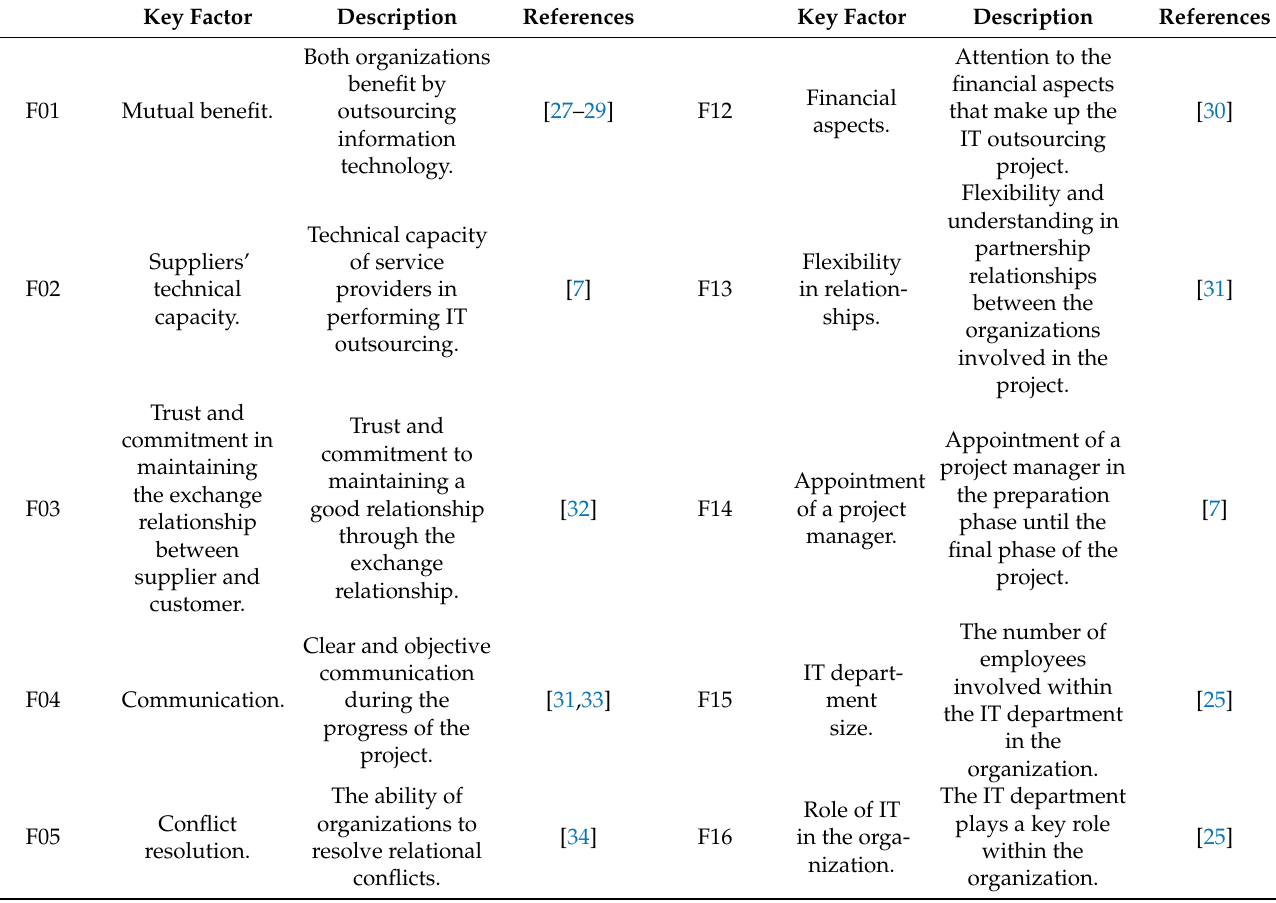
Table 1. Key factors in ITO according to the literature on the